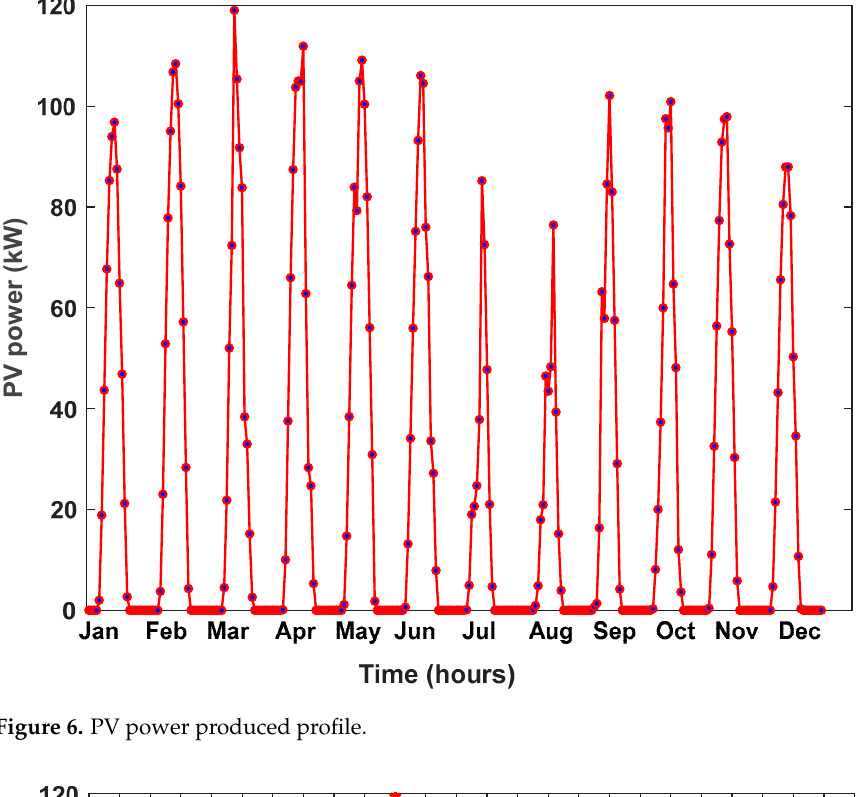
Figure 6. PV power produced profile.